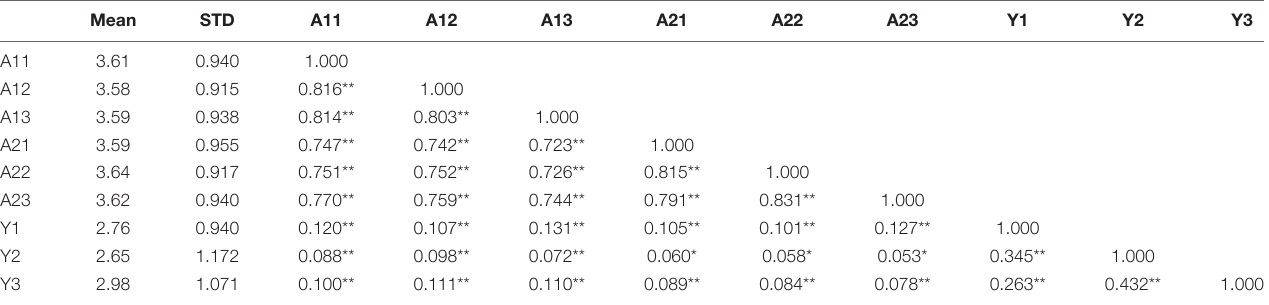
TABLE 2 | Descriptive statistics and correlation analysis.